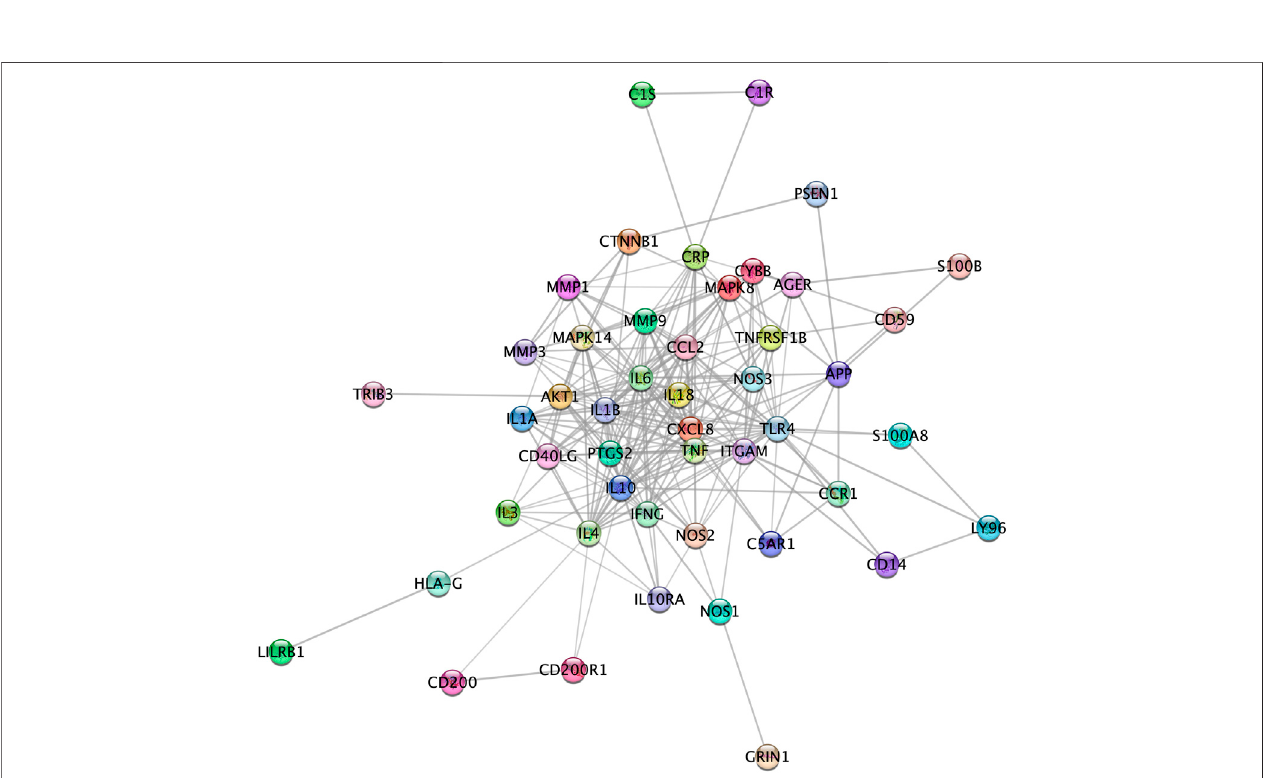
FIGURE4| Highcon fi denceprotein-proteinfunctionalinteractionnetworkofproteinsassociatedtothemostrelevantbiologicalprocessesinneuroin fl ammation in Alzheimer ’ sdisease.Amongthe52proteinsassociatedtothebiologicalprocesses,5(CD4,CHGA,GIG25,LAT2andMIF)didnotshowhighcon fi denceprotein-protein functional interaction in the network and therefore are not represented here.